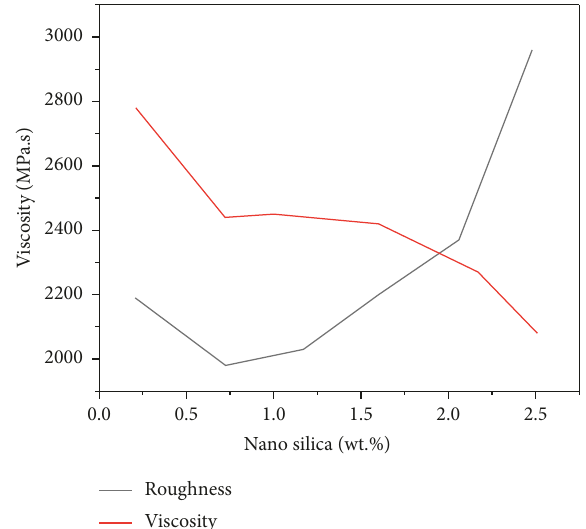
Figure 3: TG-DTG diagram of ceramic core blank.